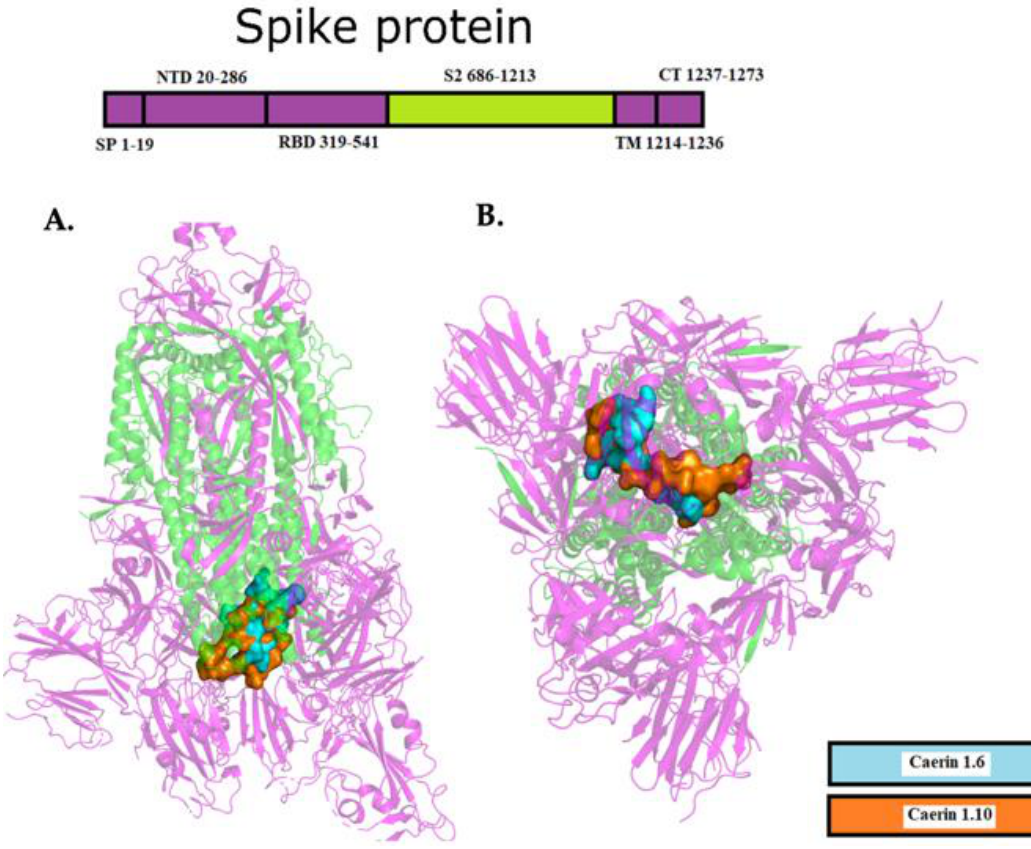
Figure 4. Docking between caerin 1.6 (blue) and caerin 1.10 (orange), and S2 domain (green) of Sgp. ( A ) lateral view of interaction; ( B ) bottom-up view of interaction.